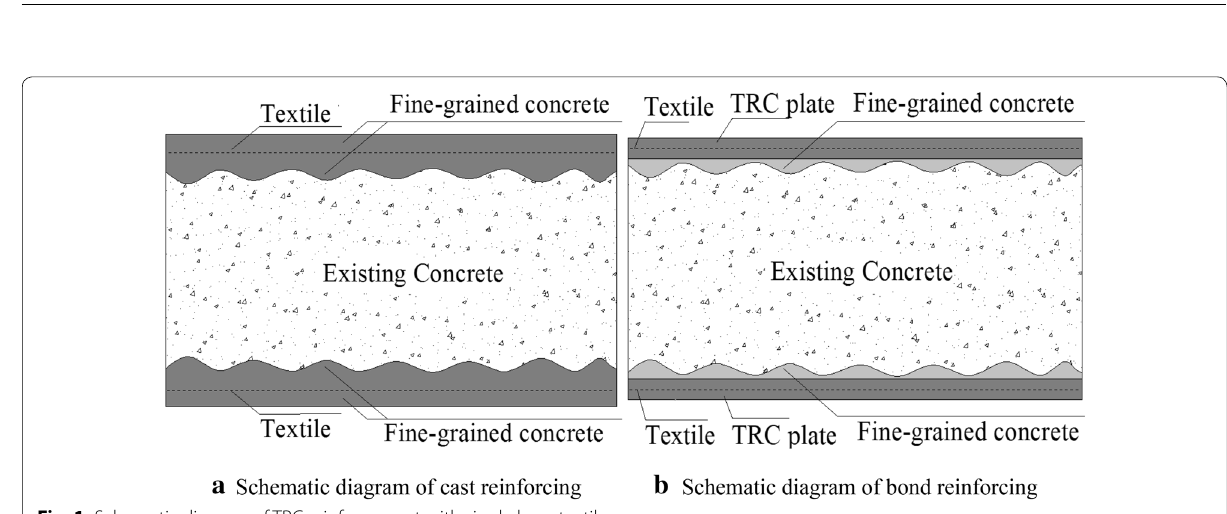
Fig. 1 Schematic diagram of TRC reinforcement with single layer